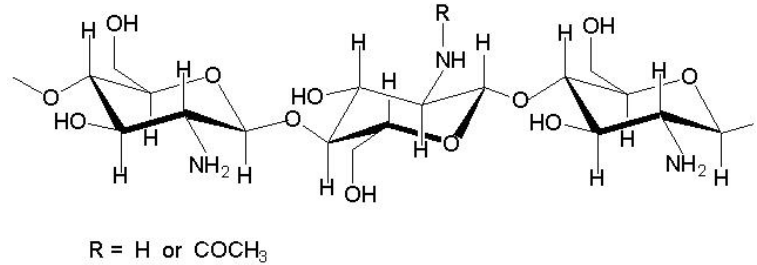
Figure 2. Chitosan structure